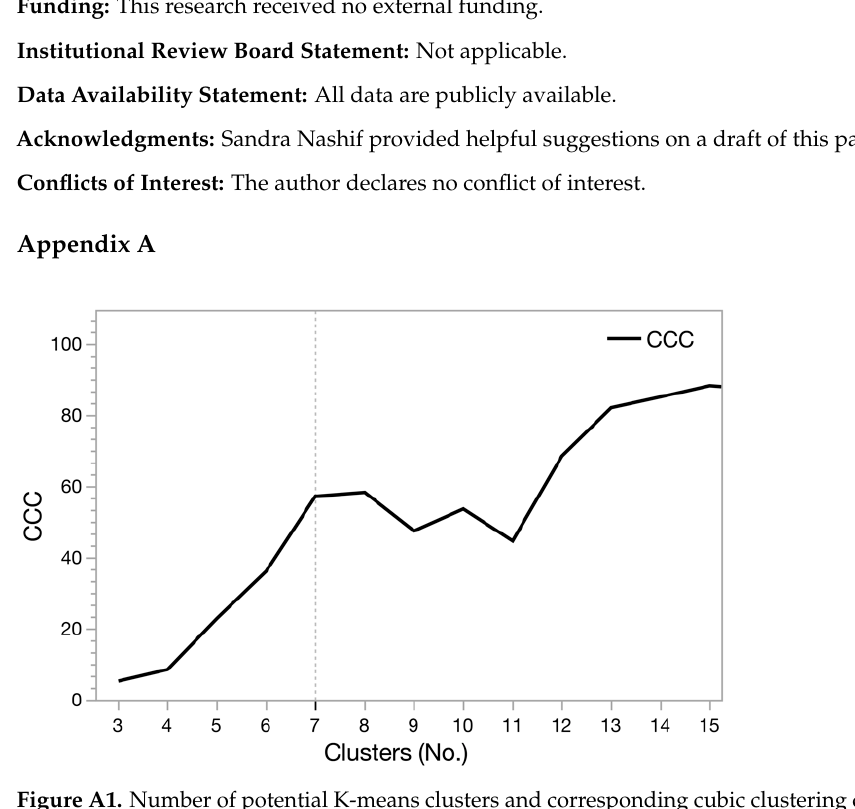
Figure A2. Municipalities in the study area by ( a ) crop portfolio designation and ( b ) relative crop species diversity (Shannon Effective Diversity) quartiles.